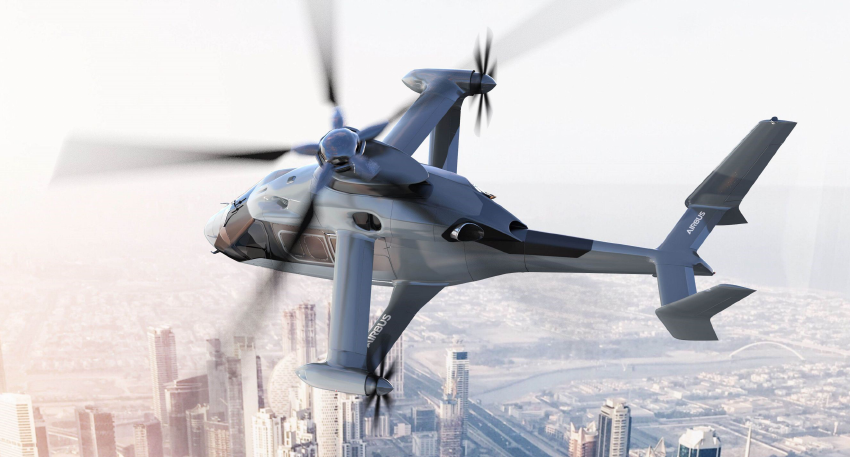
Figure 1. Rapid And Cost-Effective Rotorcraft (RACER)